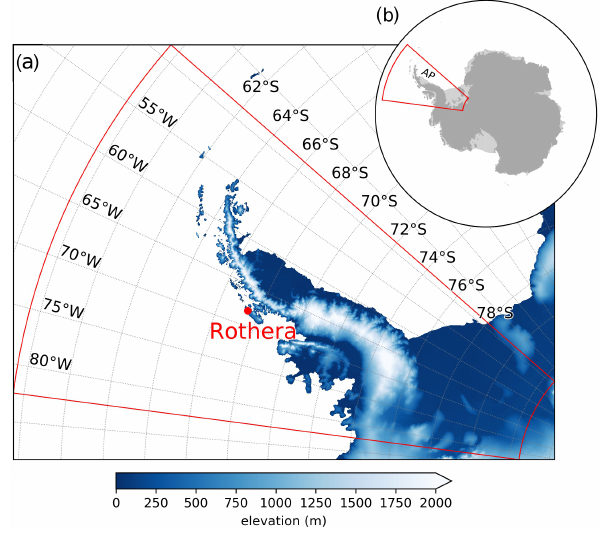
Figure 1. Maps of the (a) Antarctic Peninsula region showing the box used to compute both the parameterised and AIRS results, as well as the location of Rothera Research Station where the radioson- des are launched and the elevation of the orography, and (b) Antarc- tica, with the locations of both the box and the Antarctic Penin- sula (AP) indicated. Note that orography dataset used in panel (a) is Bedmap2 (Fretwell et al.,